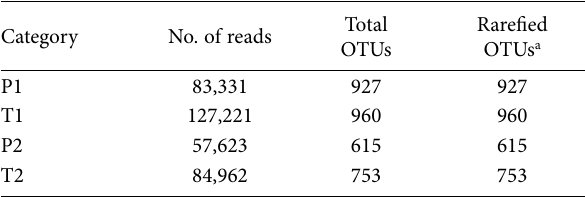
Table 1. Sequencing results obtained from analyses of DNA extract- ed from cultured mycelium isolated from four wheat variety and field categories: P1 = Perciasacchi from Field 1; T1 = Tumminia from Field 1; P2 = Perciasacchi from Field 2; and T2 = Tumminia from Field 2.